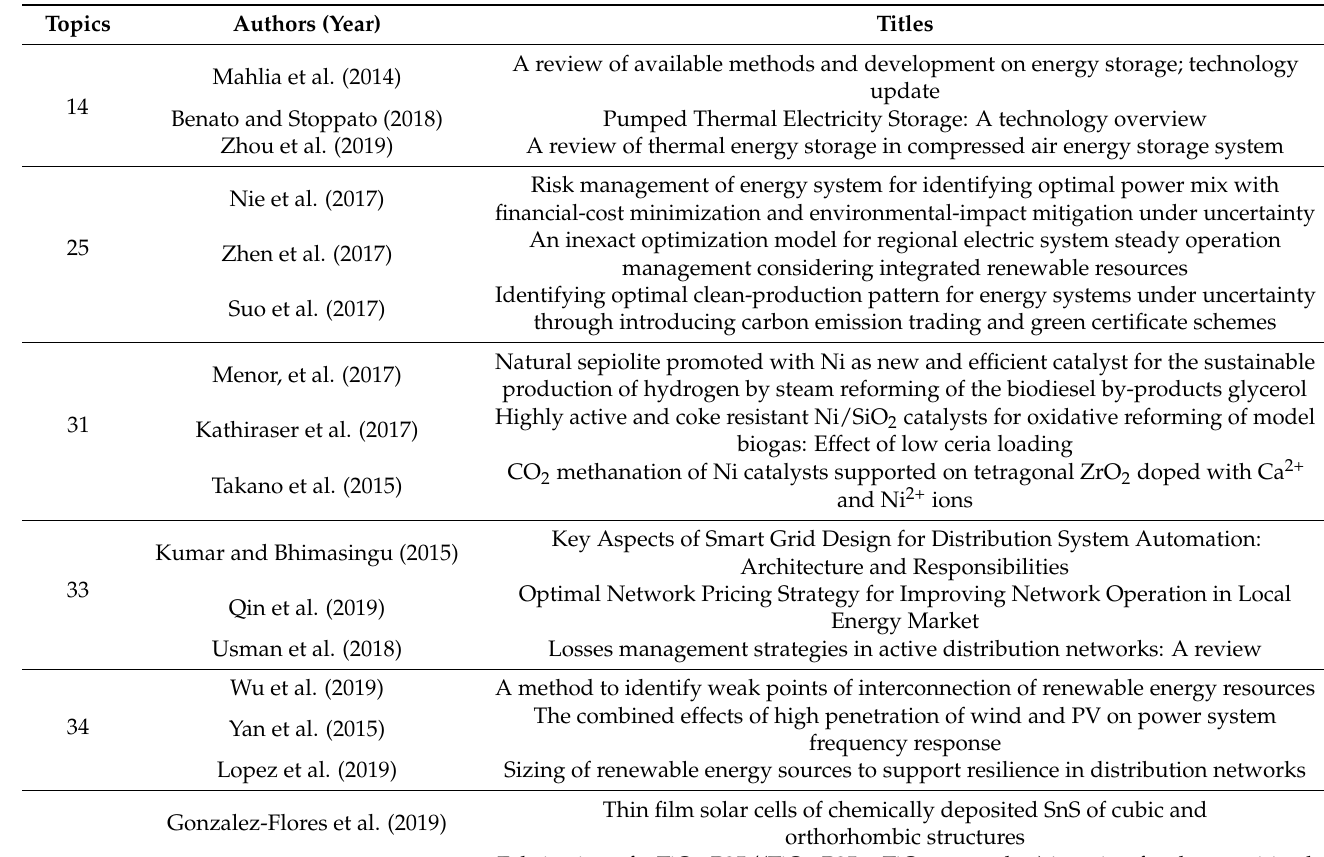
Table 6. Relevant documents with weak signal topics 1